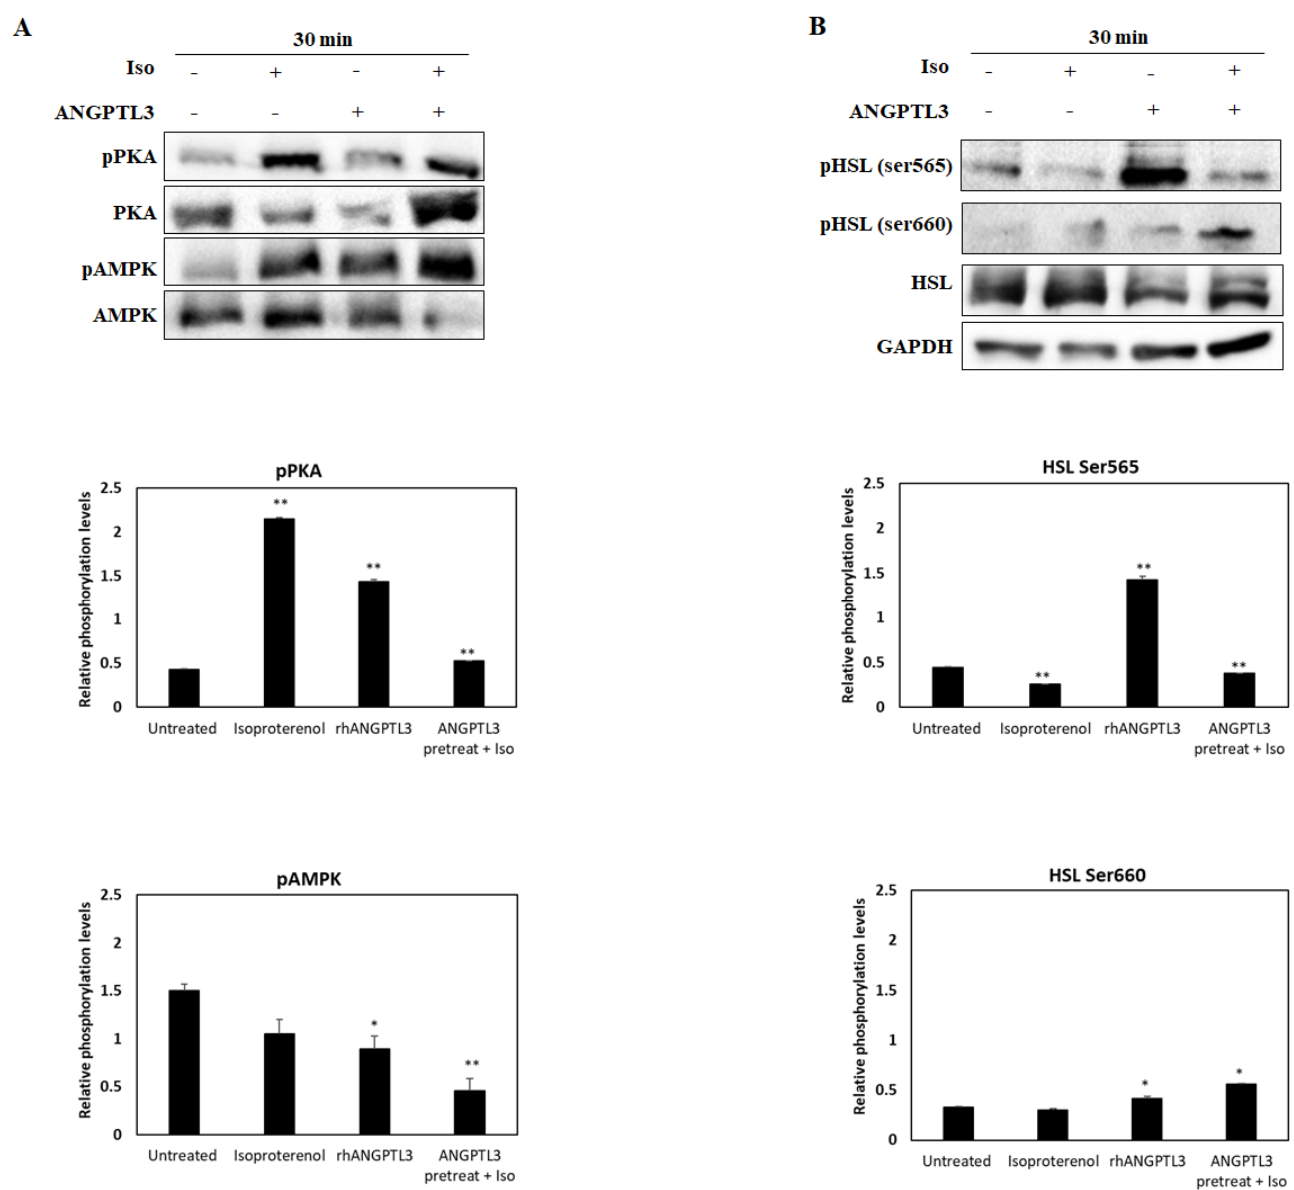
Figure 3. Lipolysis activation in ISO and ANGPTL3-treated cells. Representative blots of phosphorylated and total levels of AMPK and PKA in Panel A . Representative blots of phosphorylated and total levels of HSL ( Panel B ) in 3T3-L1 adipocytes treated for 30 min with recombinant human ANGPTL3 (ANGPTL3), ISO (Iso), and both. GAPDH levels were used as the loading control. Multiple antibody hybridation. Significant differences by t -test: * p < 0.05, ** p <